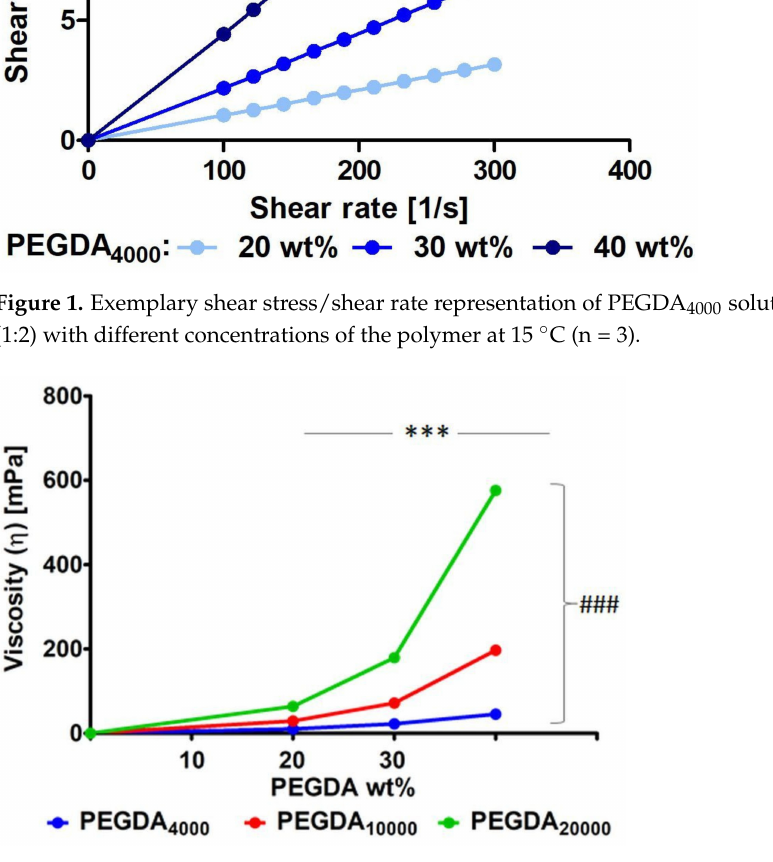
Figure 2. Average viscosity (mPa · s) for unpolymerized PEGDA solutions with different concentra- tions of the polymer in H 2 O/MeOH (1:2) at 15 ◦ C (n = 3). There were significant differences for all of the samples, marked with *** for differences between different wt % of the same polymer, and with ### for differences between the same wt % of the same polymer ( p <